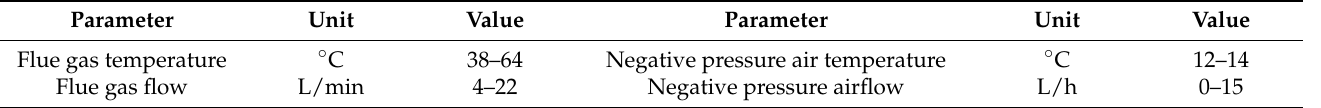
Table 2. Selection of experimental